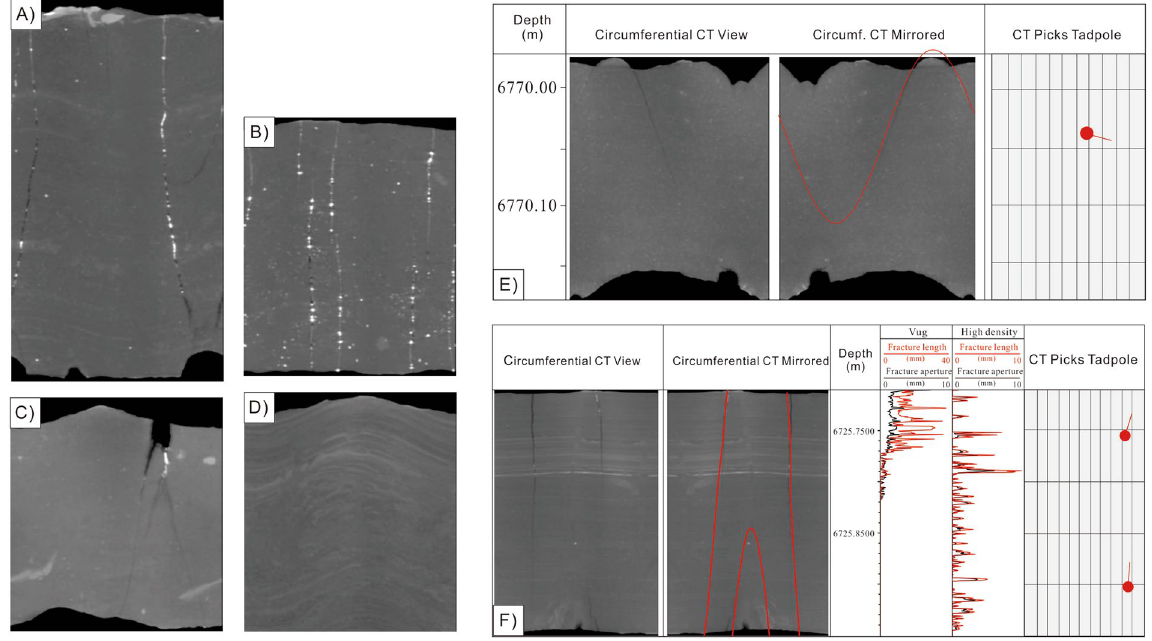
Figure 3. Hand measurements and ICT analysis of core segments. ( A ) A long, calcite-filled, hair-line (0.1 mm), extensional fracture with a lower termination is observed within the core. Well Keshen 2-2-8; 6718.42- 6718.71 m; ( B ) Segment 6680.42: four, thin-aperture (0.4–0.8 mm), calcite-filled, extensional fractures that are oblique to bedding. ( C ) Segment 6767.5 m: Two coring induced petal fractures on the edge of the core. ( D ) Segment 6734.83; No fractures. ( E ) The directional fracture measurements (azimuth and dip) were conducted on the circumferential CAT scan images. ( F ) Two-dimensional slice analysis of fracture length and aperture for both vugs (open fracture) and high density (closed fracture)